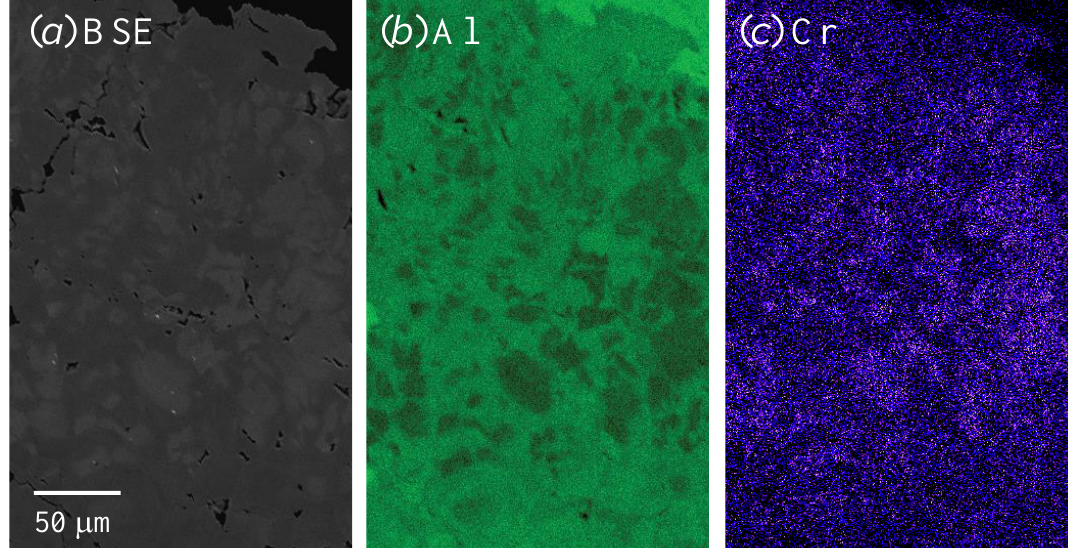
Figure 5. Uv sample 2 from Switzerland: ( a ) BSE image contains light and dark patches that indicate different compositions. The X-ray elemental maps show the inverse distribution of ( b ) Al and ( c ) Cr atoms. The Fe and Mg maps are homogeneous and are not shown. The light and dark patches are formed by dissolution and re-precipitation of the Uv crystals. The scale bar in (a) is 50 μ m.